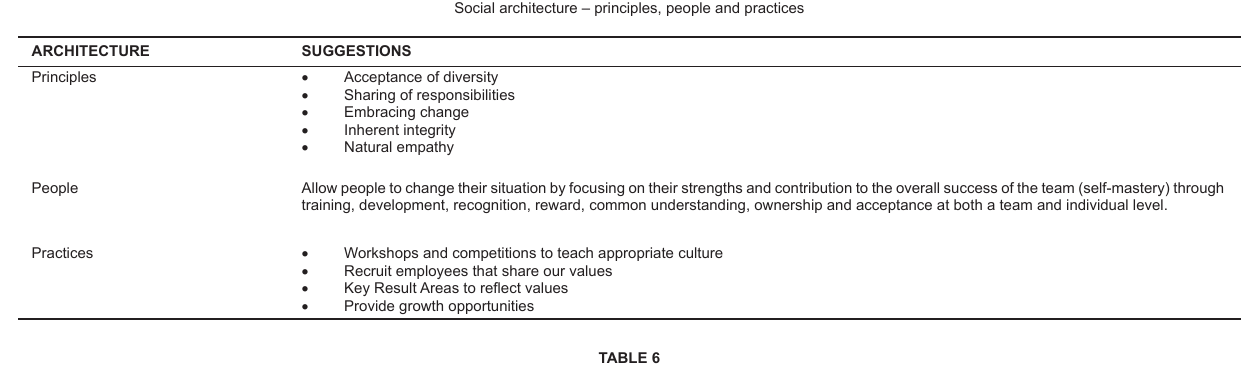
TABLE 5 Social architecture – principles, people and practices